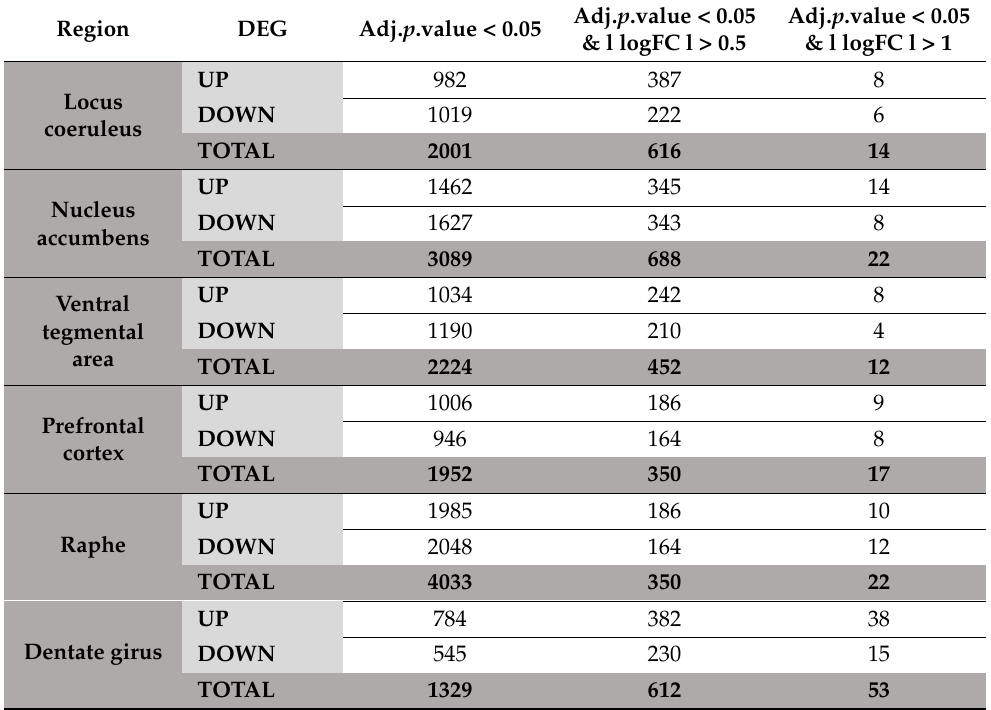
Table 1. Summary of differentially expressed genes (DEGs) in the different brain regions for different levels of stringency. Region DEG Adj. p .value < 0.05